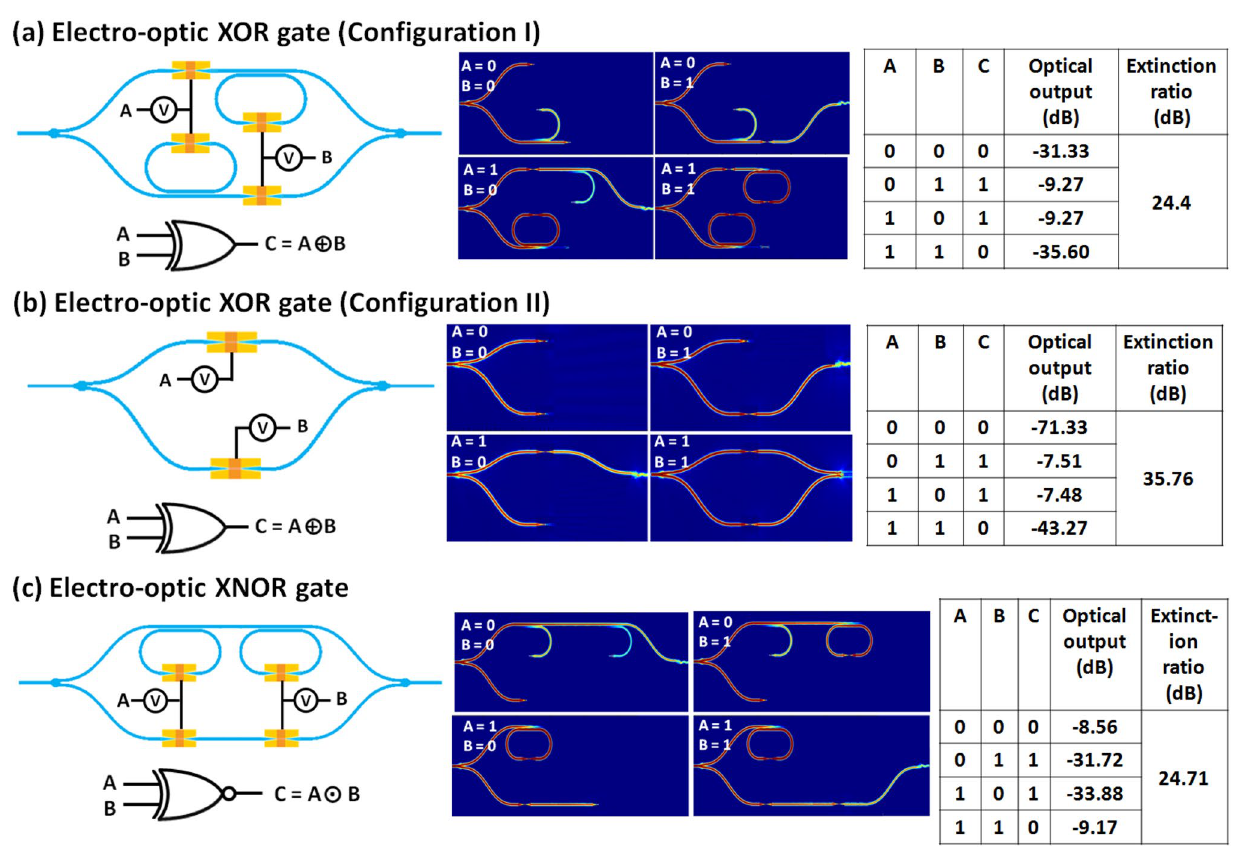
Figure 5. Electro-optic configurations, graphical symbols, and truth tables of: ( a ) XOR logic (configuration 1), ( b ) XOR logic (configuration 2), and ( c ) XNOR